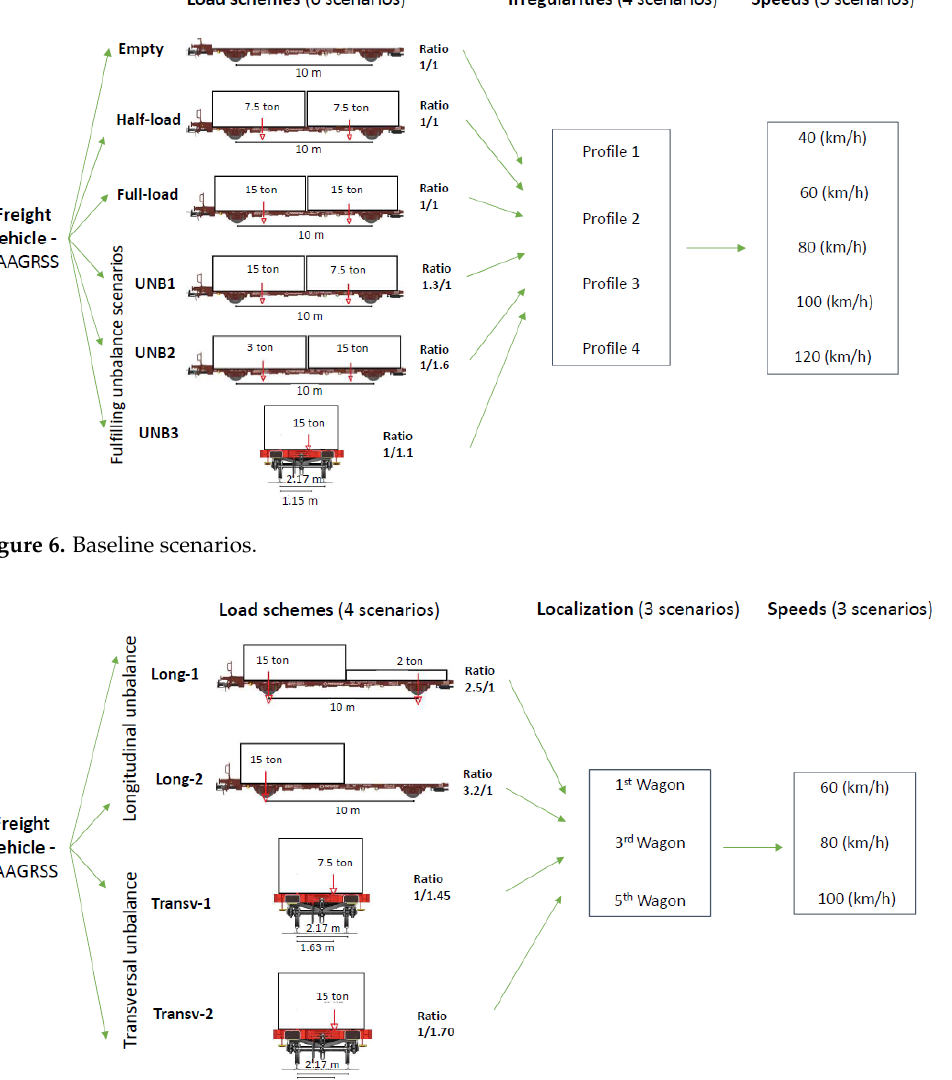
Figure 6. Baseline scenarios.